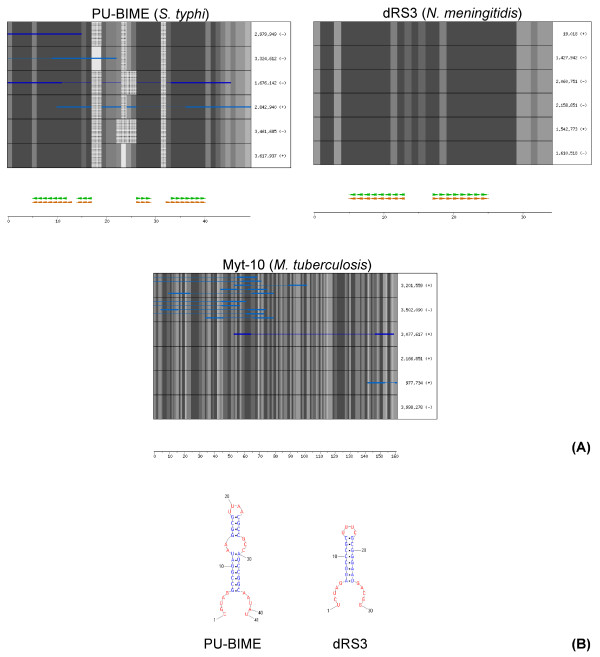
Alignment of PU-BIME, dRS3 and Myt-10 family members. Panels A and B legends are as in Figure 2.